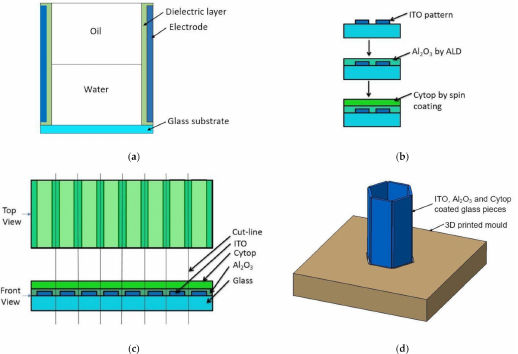
Figure 5. The fabrication process, ( a ) section view schematic of the cell, ( b ) layer depositon sequence, ( c ) di ff erent layers on a glass slide before dicing, and ( d ) assembled hexagonal cell of six coated glass pieces placed in a 3D-printed